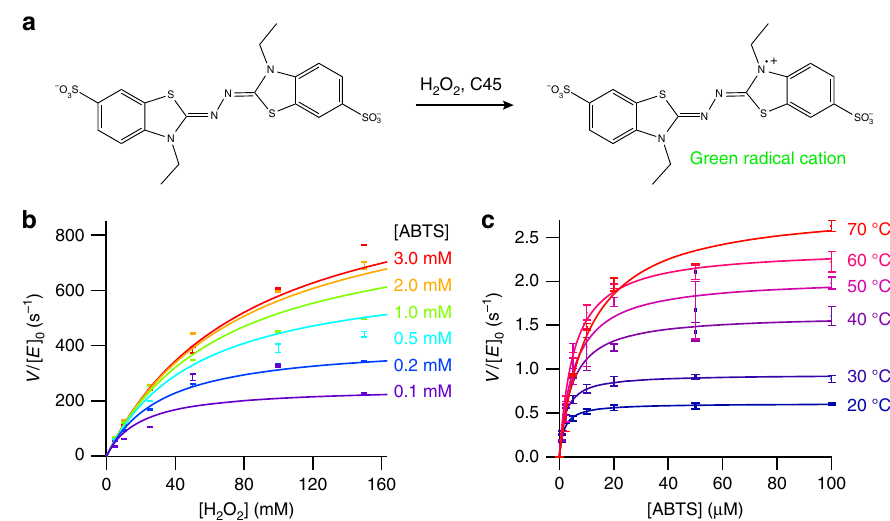
Fig. 2 Steady-state kinetics of ABTS and hydrogen peroxide turnover by C45. a Transformation of ABTS to a green radical cation as catalyzed by natural peroxidases and C45. b Steady-state kinetics plot for ABTS turnover by C45 at varying [ABTS] and [H 2 O 2 ]. Data are fi t to a ping-pong steady-state kinetics model. c The thermal stability of C45 enables classical Michaelis – Menten kinetics to be determined up to 70 °C. All data were recorded in triplicate and error bars represent the standard deviation. Michaelis – Menten parameters for the data contained in c are presented in Supplementary Table 1. Kinetic data were collected in 20 mM CHES, 100 mM KCl, pH 8.58 with 0.1 μ M